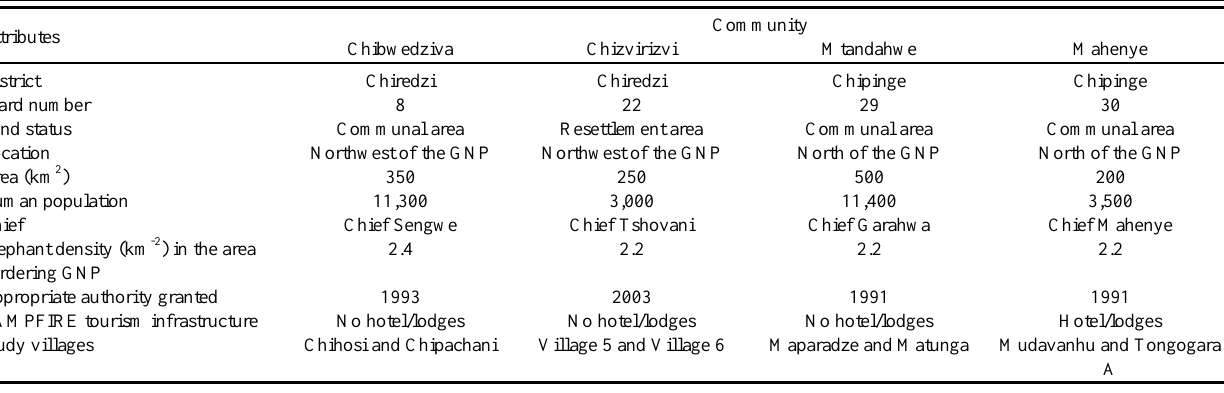
Table 1 . General characteristics of the four study communities adjacent to the northern Gonarezhou National Park (GNP), Zimbabwe. Source: Hlambela and Kozanayi (2005), Mashinya (2007), Dunham et al.